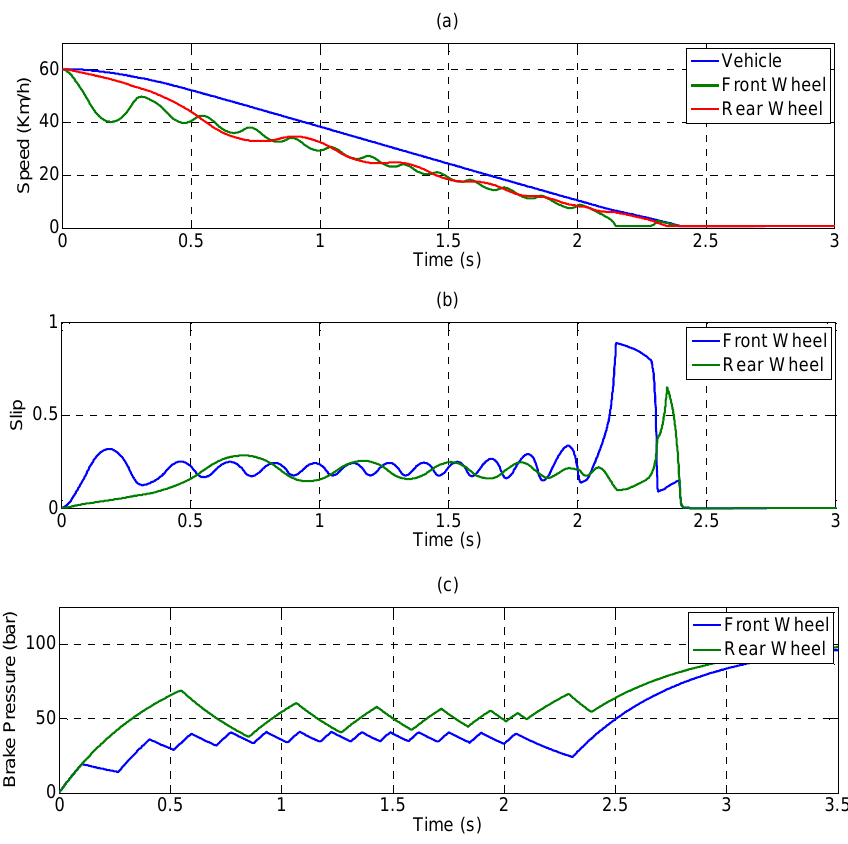
Figure 18. EHB performing anti-lock braking on a dry road surface: ( a ) vehicle speed and wheel speed; ( b ) slip; and ( c ) brake pressure.